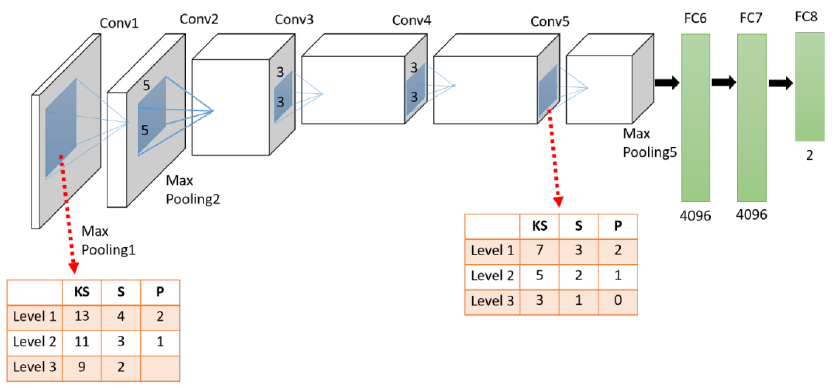
Figure 4. Diagram of structural parameter optimization in the AlexNet.